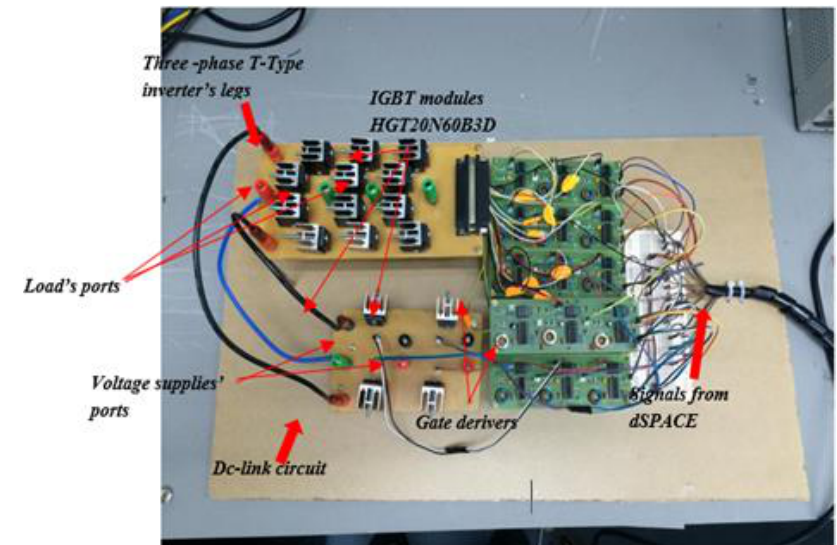
Figure 5. The experimental setup photo.